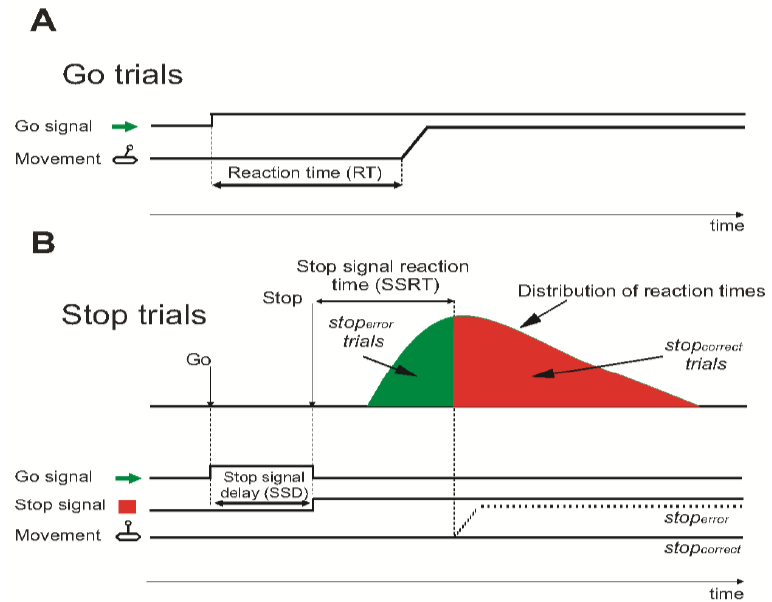
Figure 2. Schematic representation of the cognitive–motor task. ( A ) In Go trials, the subjects had to respond by moving a joystick at the presentation of a green arrow to generate the reaction time (RT). ( B ) In stop trials, they had to suppress the ongoing movement if a red square was presented in the interval within the reaction time window of the Go trial. The interval between presentation of the stop signal and suppression of movement represented the stop signal reaction time (SSRT).